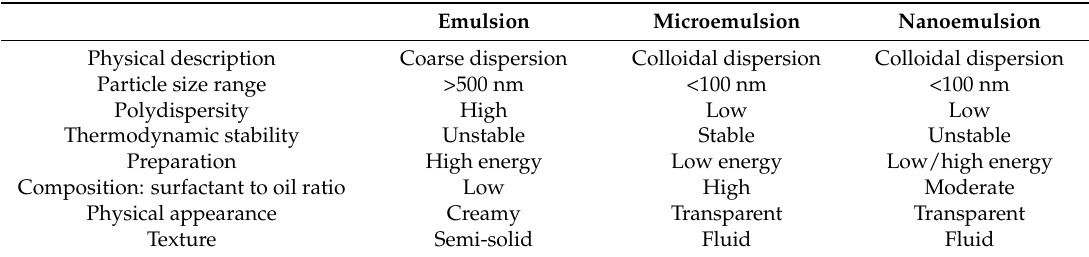
Table 1. Comparison of the properties of emulsions, microemulsions and nanoemulsions. Emulsion Microemulsion Nanoemulsion Physical description Coarse dispersion Colloidal dispersion Colloidal dispersion Particle size range >500 nm <100 nm <100 nm High Low Thermodynamic stability Unstable